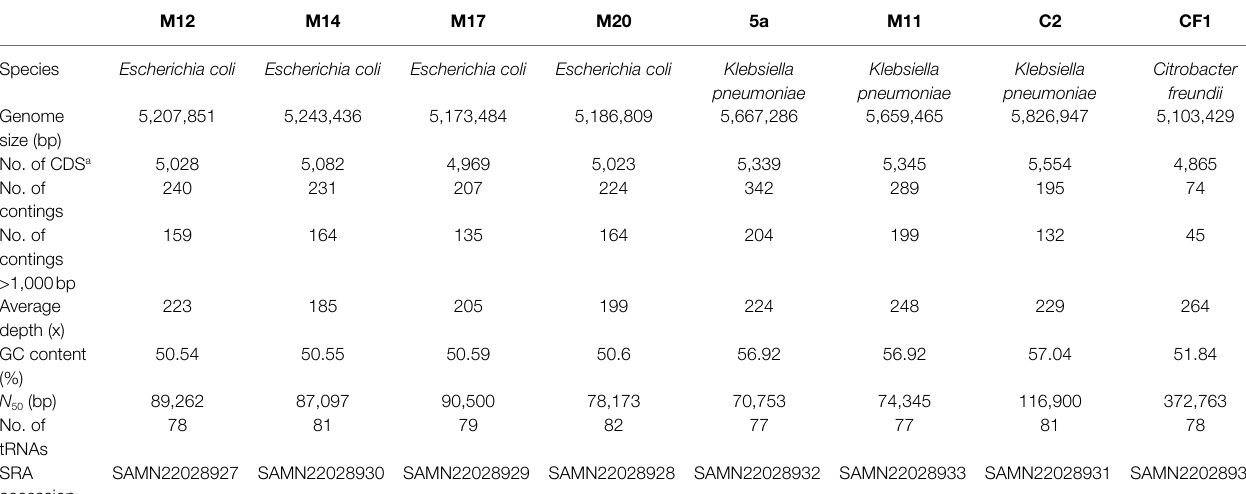
TABLE 2 | Metadata of the whole-genome sequenced CRE isolates from